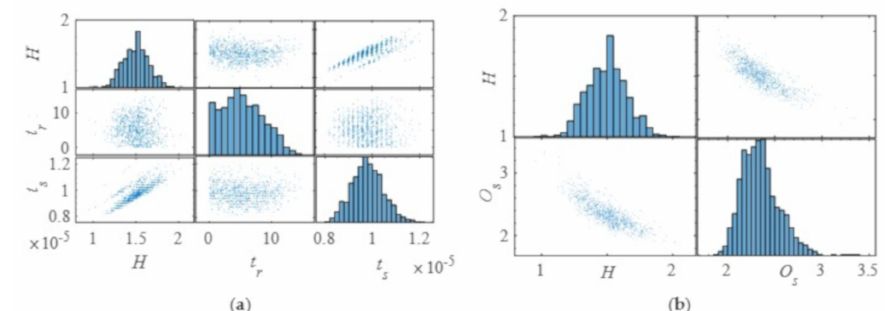
Figure 12. The influence of the wind − solar − hydro system parameters on the DPIs of the angular velocity of PSPP. ( a ) The influence of H on the settling time. ( b ) The influence of H on the